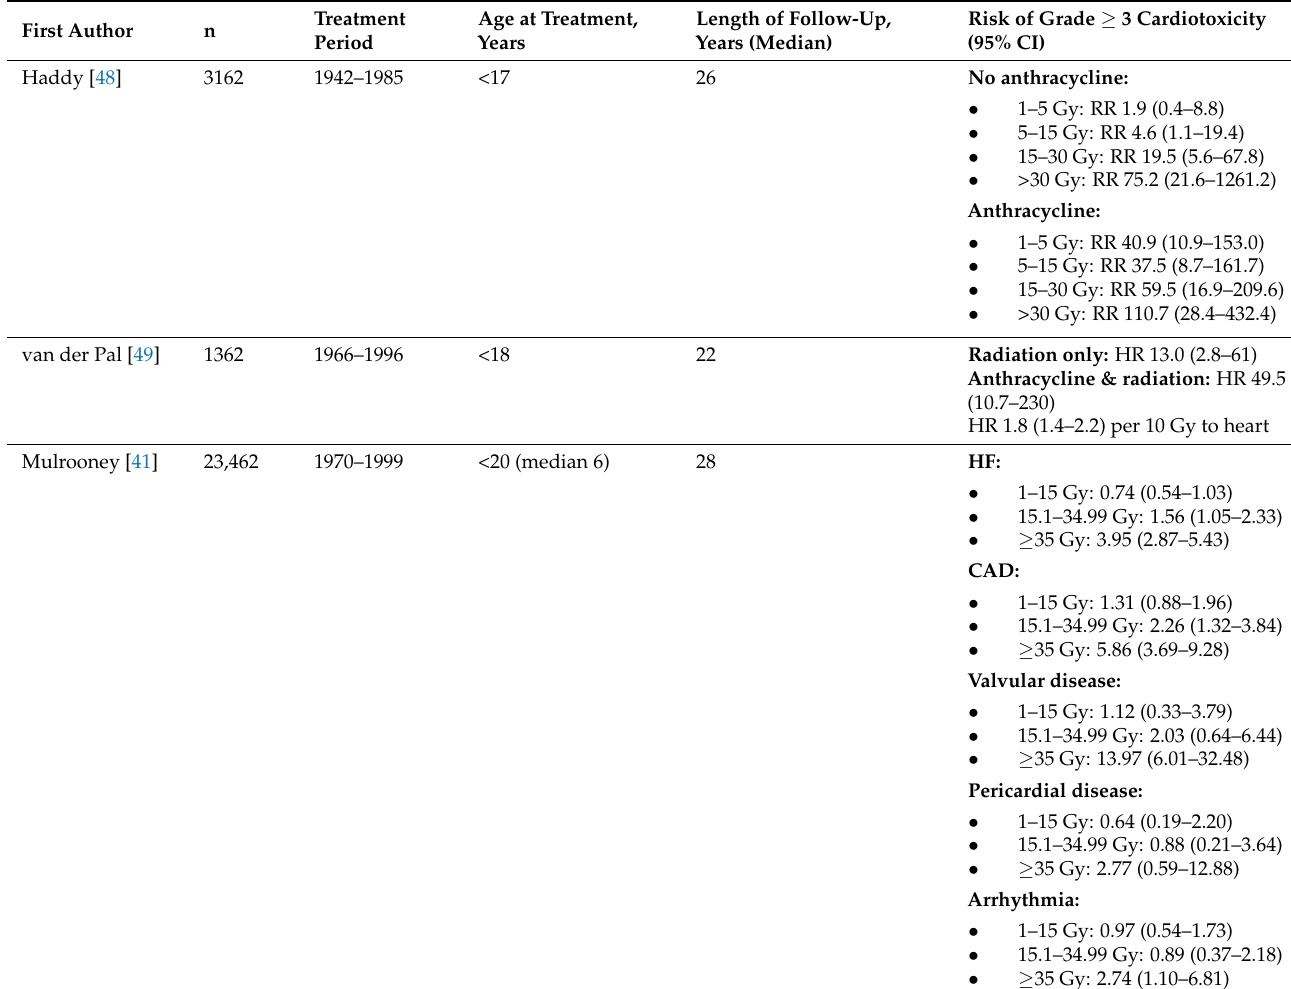
Table 2. Studies exploring the association of radiation dose with risk of grade ≥ 3 cardiac toxicity in adult survivors of childhood cancers. The reference group comprised adult survivors or childhood cancers without the cardiotoxic exposure. Higher radiation dose to the heart was associated with an increased risk of grade ≥ 3 cardiotoxicity. The risk was higher in patients who received anthracycline chemotherapy in addition to radiation